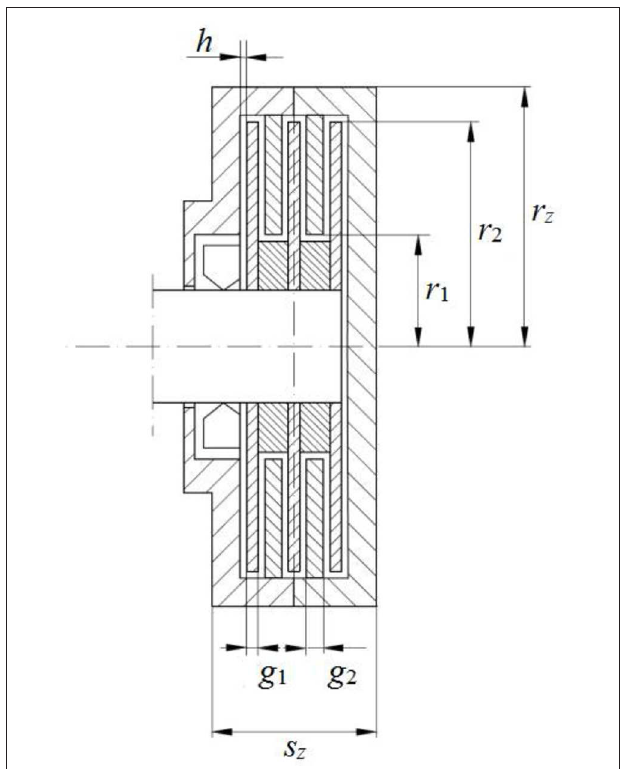
FIGURE 1 | Construction scheme of a model viscous clutch with ER fluid with 5 discs. where T is the temperature of the surroundings and S = π ( r 2 r 2 ) is the surface of the electrode’s side. 1